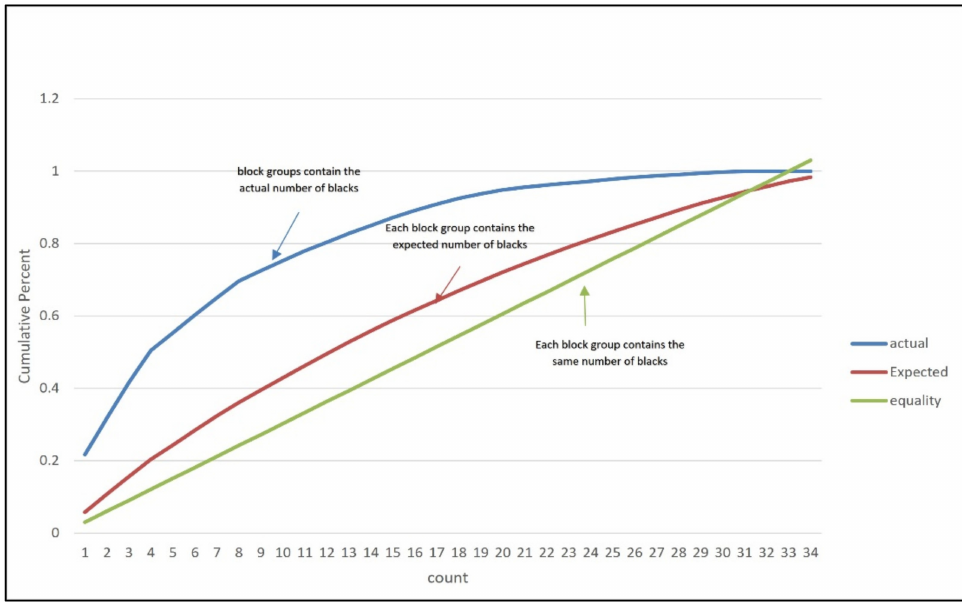
Figure 4. Cumulative Percent Curves for Blacks in Aberdeen SD. The blue curve shows the cumulative percent of the number of blacks found within the block groups. The green line displays the cumulative curve if all block groups contained the same number of blacks. This is the definition of perfect integration for the first school. The red line displays the cumulative curve where each block group contains its expected number of blacks. This is the definition of complete integration in the third school’s approach. Notice that using expected frequencies as a comparison base allows for an uneven distribution which is a much more realistic